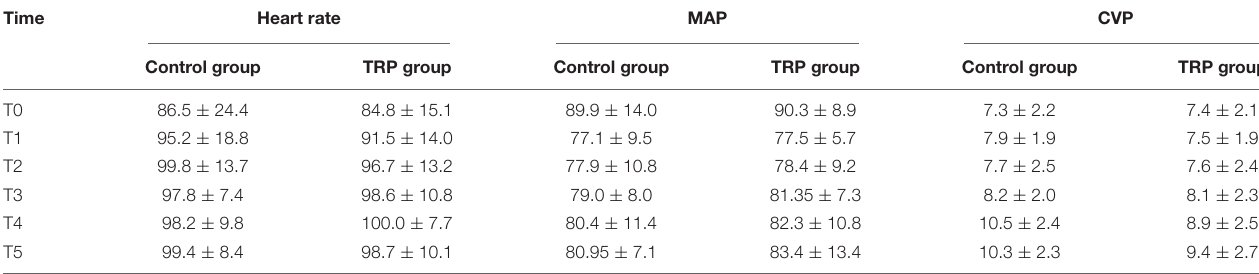
TABLE 3 | Patients’ perioperative hemodynamic data.